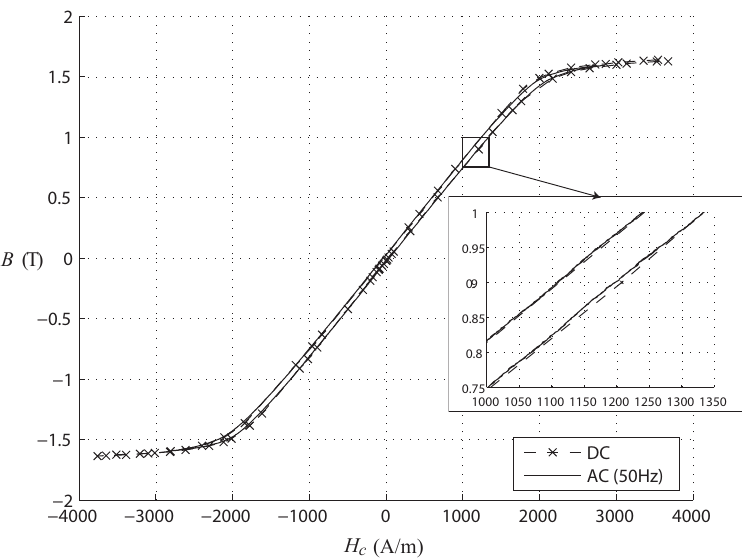
Figure 3. Hysteresis cycle of the whole